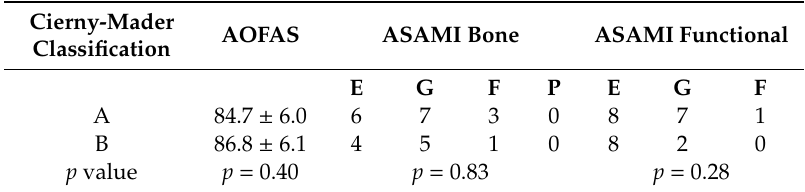
Table 4. Comparison between the results of the di ff erent Cierny–Mader classification types using the AOFAS and ASAMI Bone and Functional Scoring System.